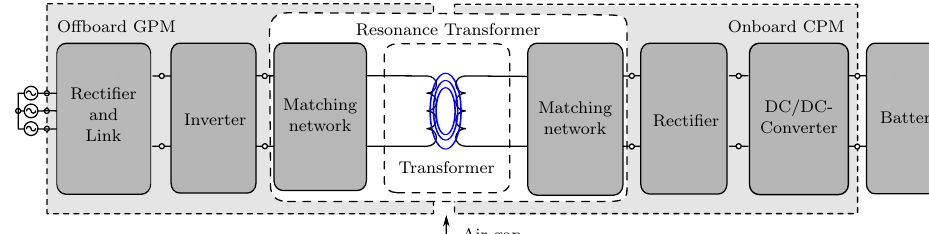
Figure 1. Exemplary wireless power transfer